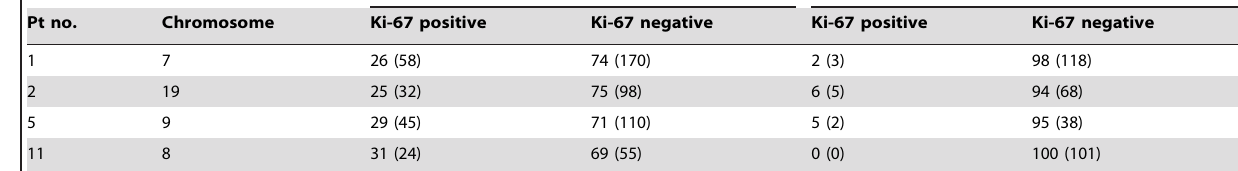
% Nuclei with 2 signals (absolute number of nuclei) % Nuclei with 3 signals (absolute number of nuclei) Pt no.